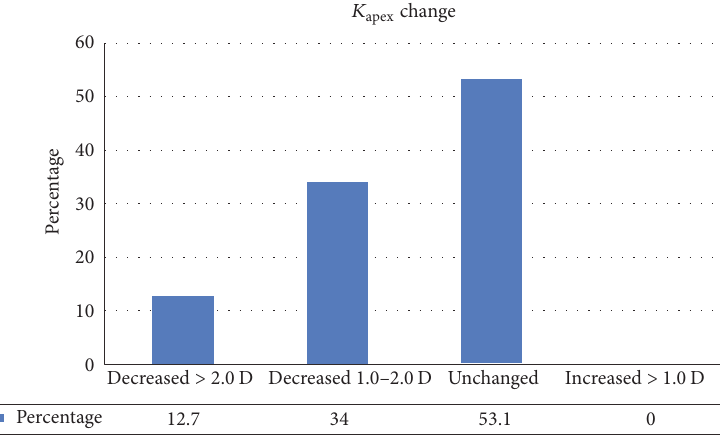
Figure 2: Changes in maximum simulated keratometry ( 𝐾